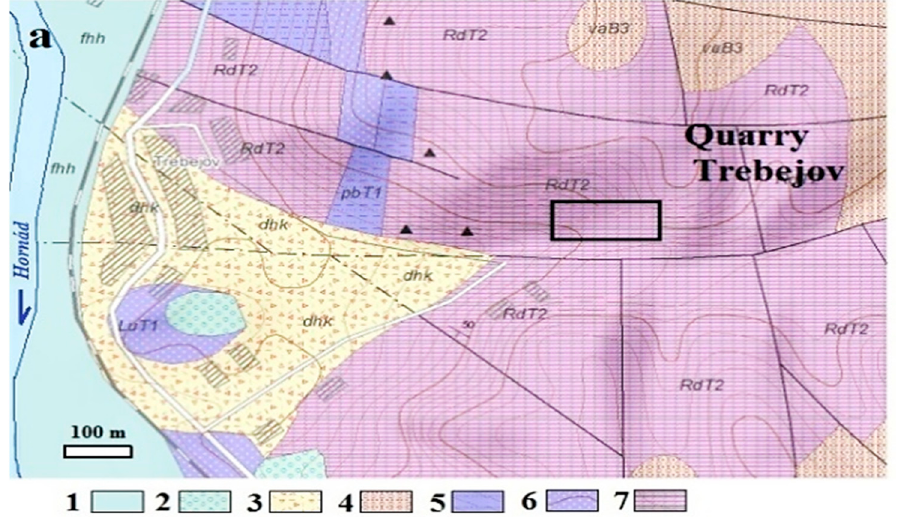
Figure 2. Geological map of the surroundings of Trebejov Quarry [48].